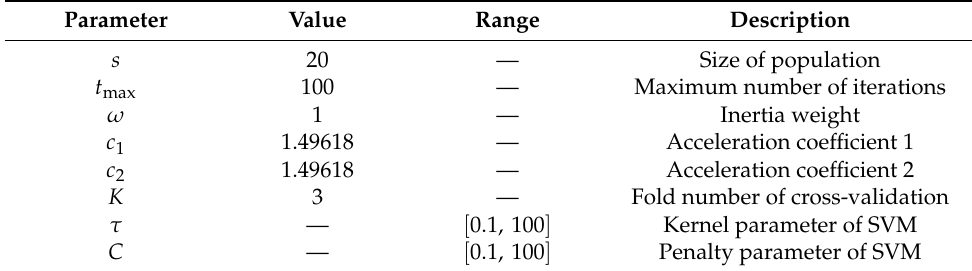
Table 1. The initialization parameters of PSO.